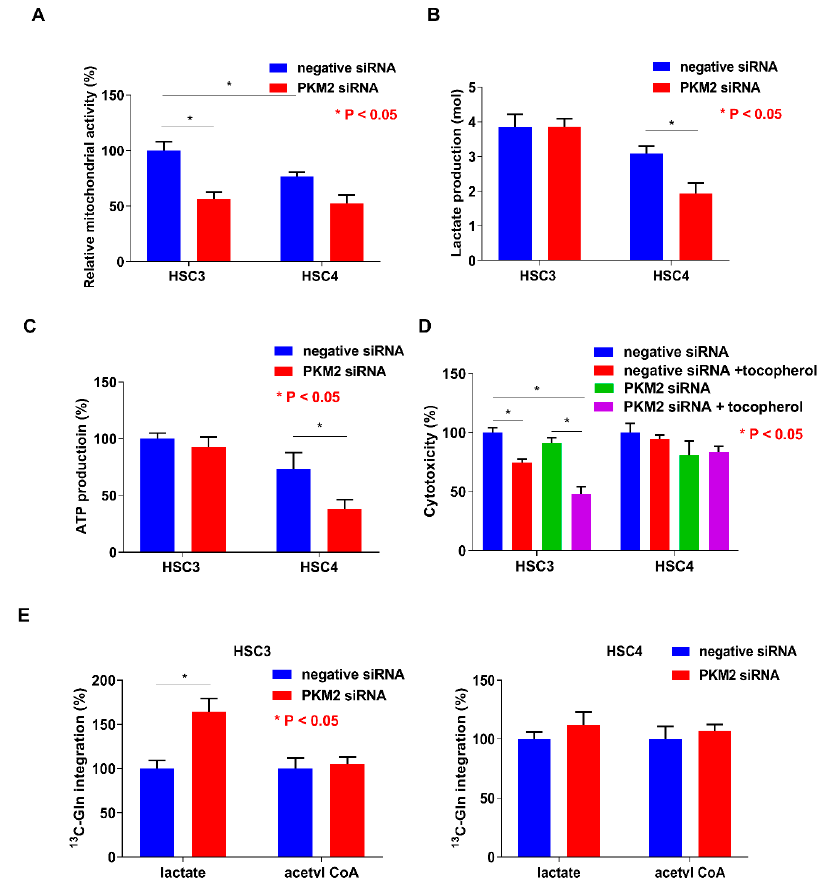
Figure 5. Functions of pyruvate kinase M2 (PKM2) in HSC3 and HSC4 cells. Influence of PKM2 knockdown on mitochondrial activity ( A ), lactate production ( B ), ATP production ( C ), cytotoxicity ( D ), and 13 C-glutamine integration into lactate and acetyl CoA ( E ) in HSC3 and HSC4 cells. Error bar: standard deviation. RQ: relative quantification.